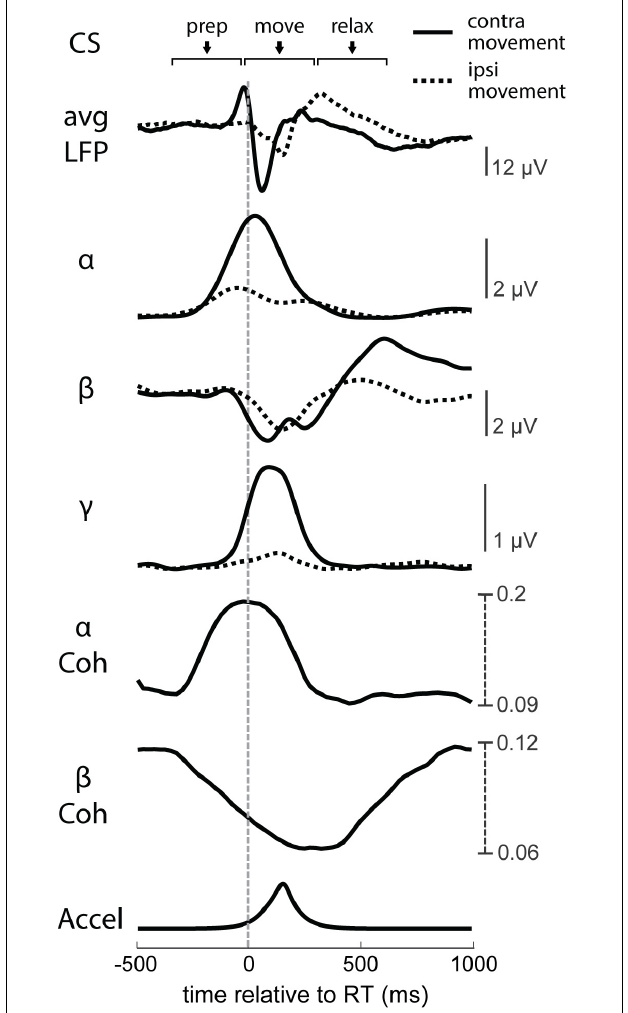
FIGURE 9 | Neural dynamics of movement. RT-averaged raw LFP, instantaneous alpha ( α ), beta ( β ), and low gamma ( γ ) intrahemispheric amplitudes, interhemispheric α and β coherence (Coh), and processed accelerometer signal (Accel). Solid lines depict the contralateral hemisphere’s trial-triggered averages, and dashed lines depict the ipsilateral hemisphere’s trial-triggered